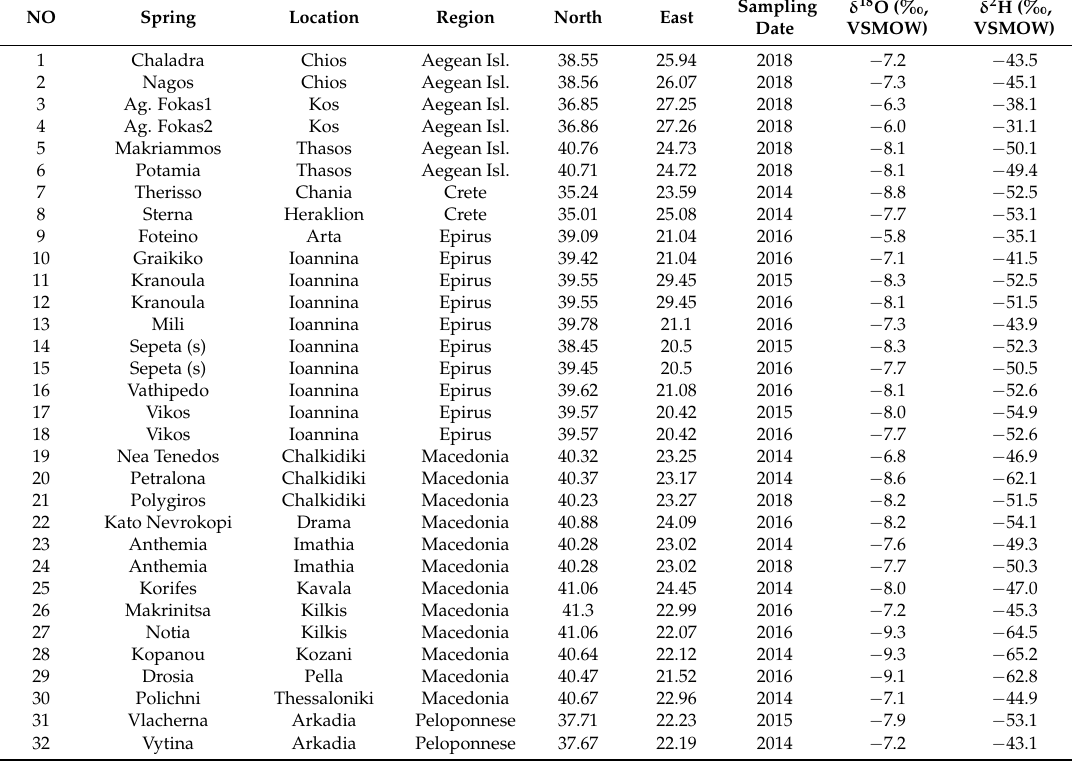
Table 1. General isotopic ( δ 18 O and δ 2 H) values of 74 Greek spring waters. Location